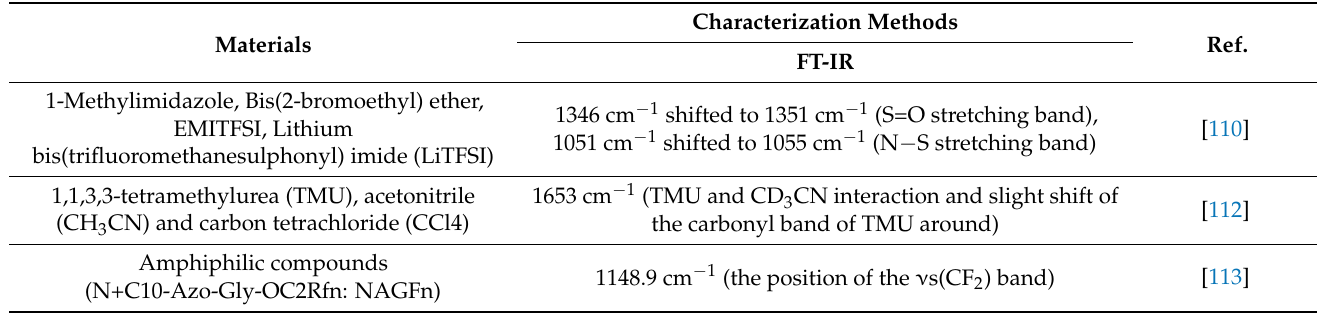
Table 6. Overview of characterization methods for dipole–dipole